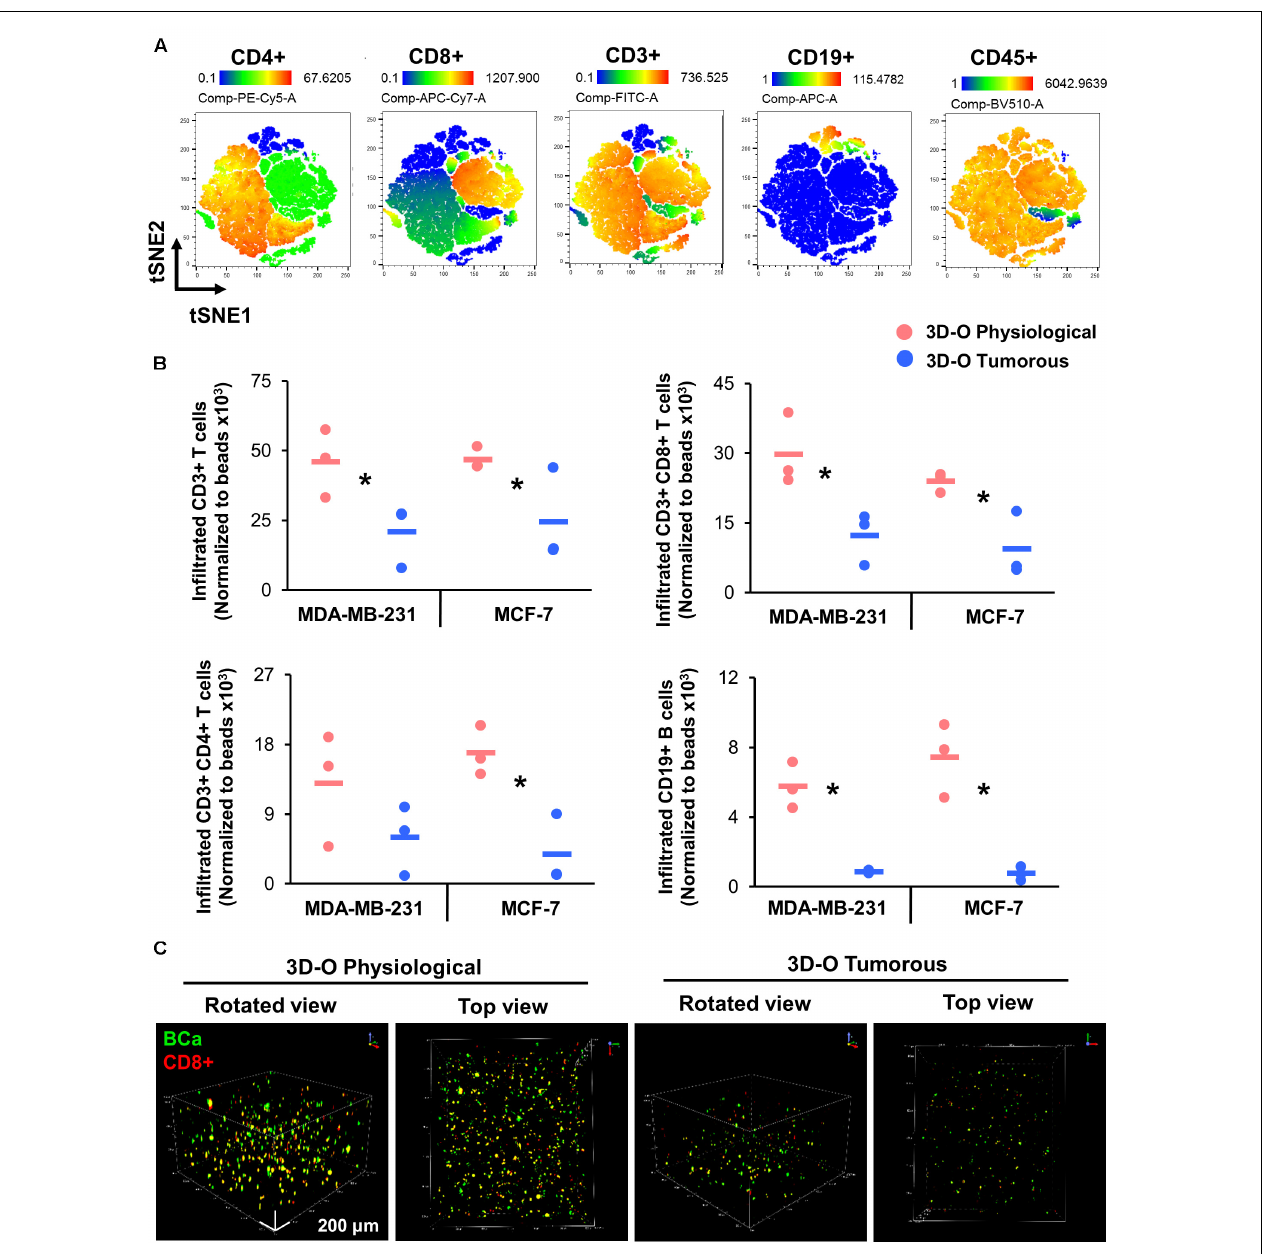
FIGURE 7 | Low-oxygen within 3D-O matrices reduces lymphocyte infiltration. (A) tSNE plot of pre-processed, single, live cells, down-sampled to 10.000 events and concatenated showing major immune clusters (CD3-FITC+, CD4-PE-Cy5+, CD8-APC-Cy7+, CD19-APC+ and CD45-BV510+). (B) Quantification of the number of infiltrated lymphocytes into 3D-O physiological and 3D-O tumorous matrices embedded with either MDA-MB-231 cells or MCF-7 cells by manual gating. Infiltration data shown represents PBMCs obtained from 3 individual healthy subjects and the average of infiltrated CD3+ T cells, CD3+CD8+ T cells, CD3+CD4+ T cells, and CD19+ B cells (data normalized to counting beads x10 3 ), * p < 0.05, data were analyzed using unpaired two-tailed Student’s t -test. (C) Representative confocal microscopy images of rotated and top views of BCa (green) cells and CD8+ (red) cells in 3D-O physiological and 3D-O tumorous matrices on day 7, co-localization is seen in yellow. Scale bar = 200 µ